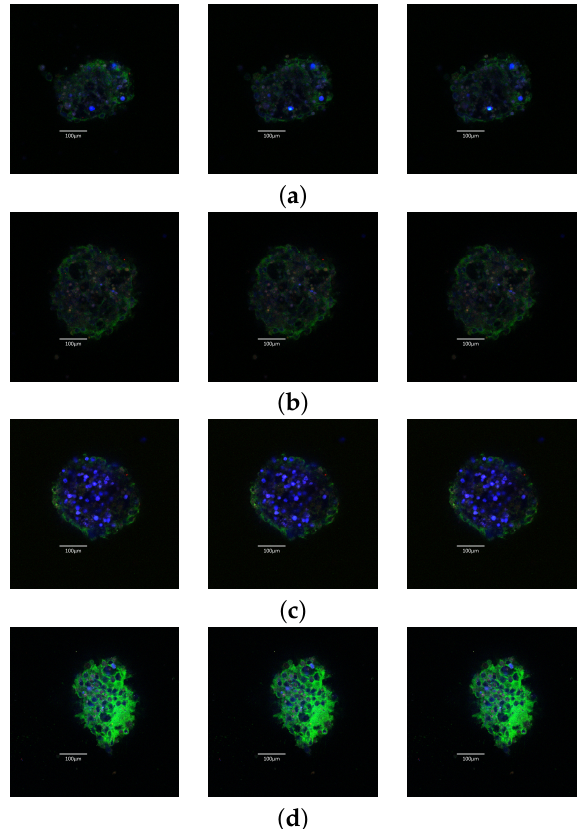
Figure 1. Sample images of each ratio for horizontal cross-section of 3D cell spheroid: ( a ) 2:0.5; ( b ) 2:1; ( c ) 2:2; ( d ) 2:4.